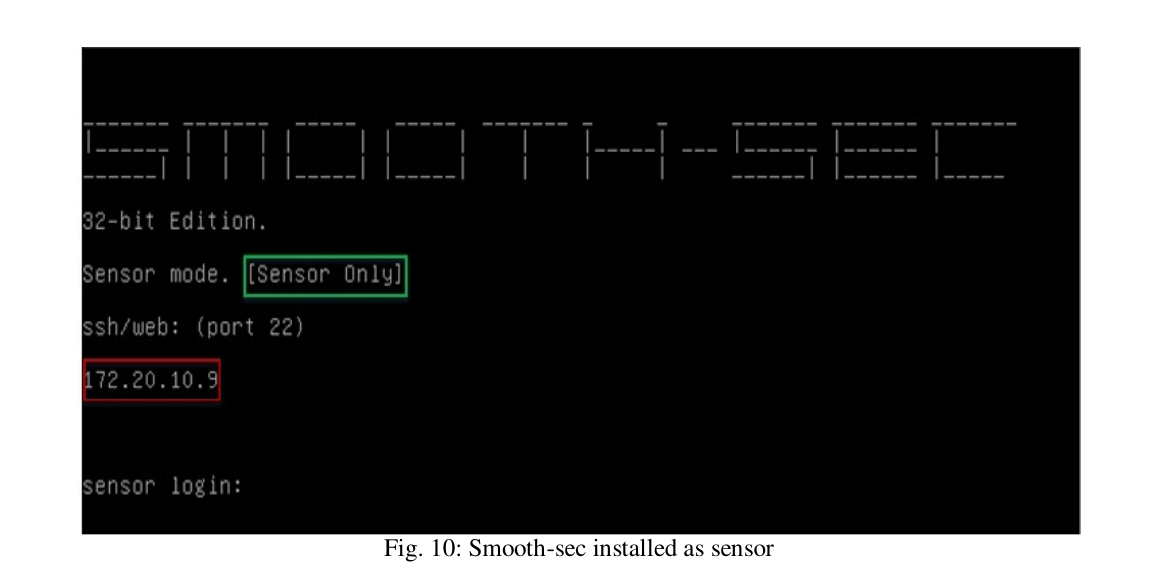
Fig. 10: Smooth-sec installed as